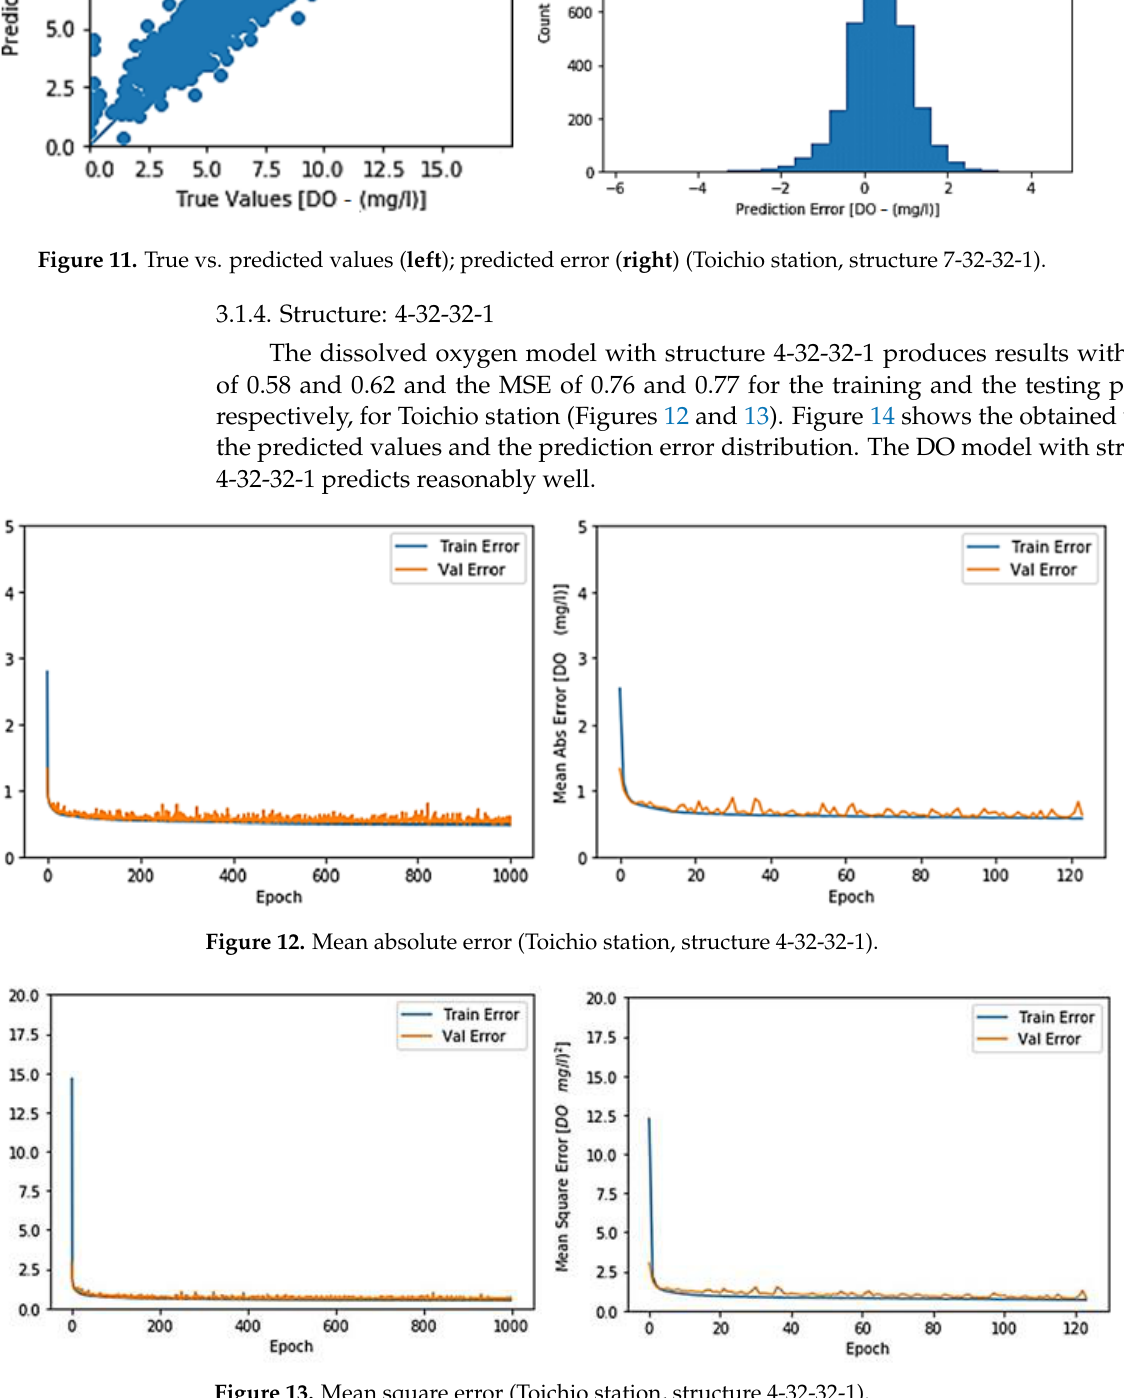
Figure 13. Mean square error (Toichio station, structure 4-32-32-1).